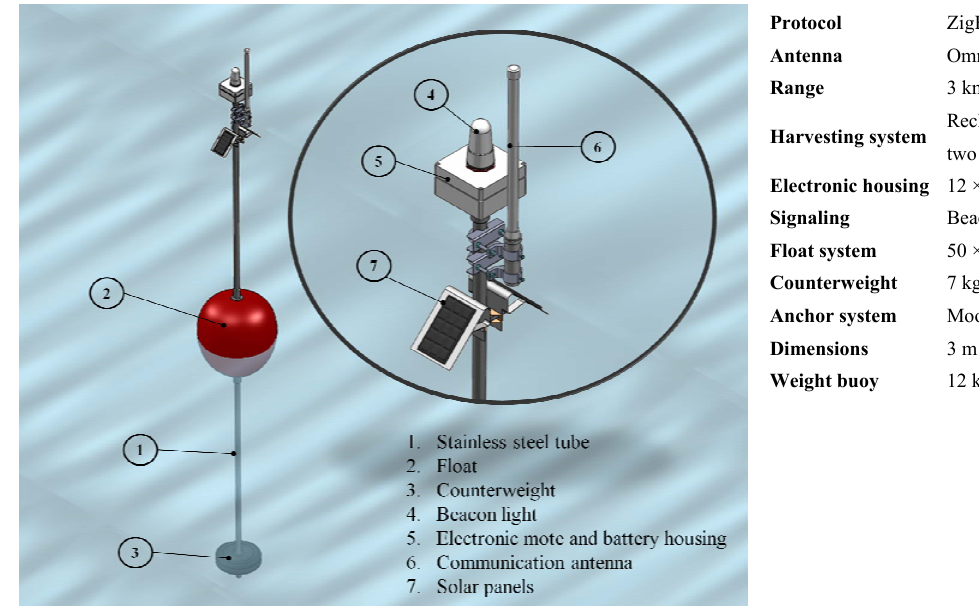
Figure 2. Mechanical structure of the buoy and its characteristics, including the adopted protocol, antenna and